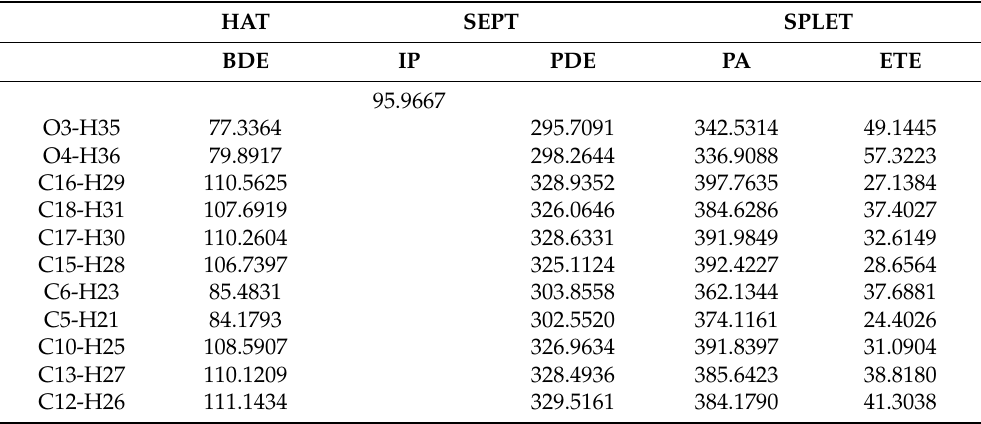
Table 3. The calculated parameters of free radical scavenging activity for LC (in kcal/mol) in gas-phase.